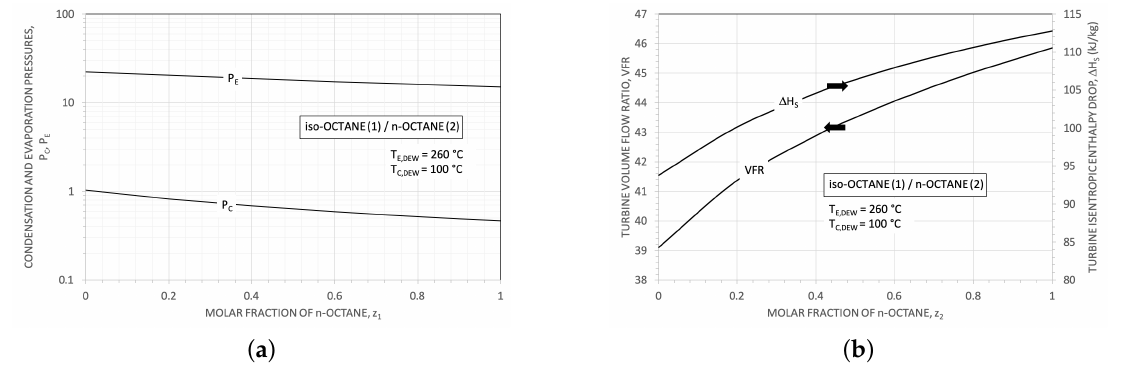
Figure 13. For a mixture of iso-octane/n-octane: ( a ) The trend of the evaporation and of the condensation pressures with the molar fraction of n-octane. ( b ) The variation of the isentropic enthalpy drop in turbine and of the isentropic volume flow ratio with the molar fraction of n-octane. Strictly correlated with the turbine expansion pressure ratio ( P E , dew / P C , dew ) are the turbine volumetric flow ratio VFR = ˙ V out / ˙ V in and the turbine isentropic enthalpy drop ∆ H S , see Figure 13b. The enthalpy drop and the VFR (by means of the so called size parameter SP ) are closely connected with the number of turbine stages and with its rotational speed